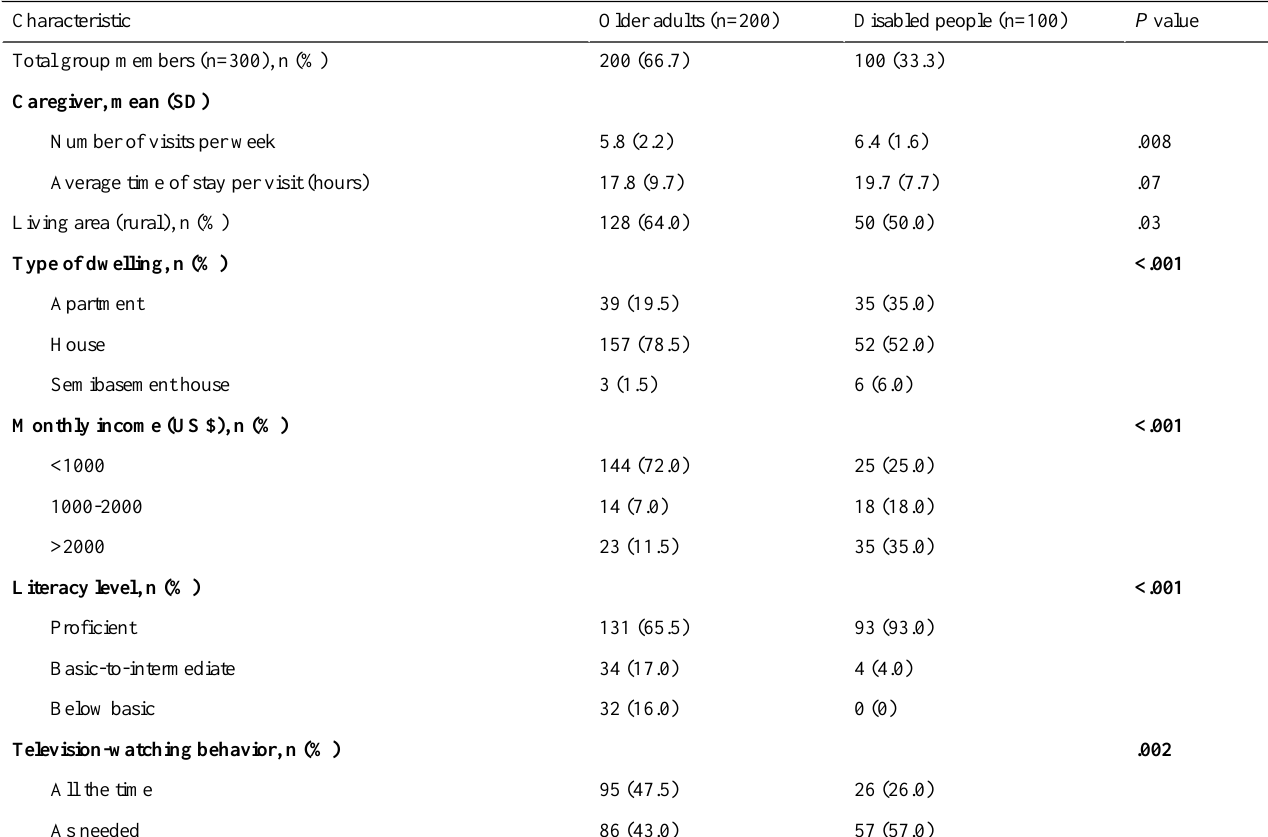
Table 2. Socioeconomic characteristics of the vulnerable